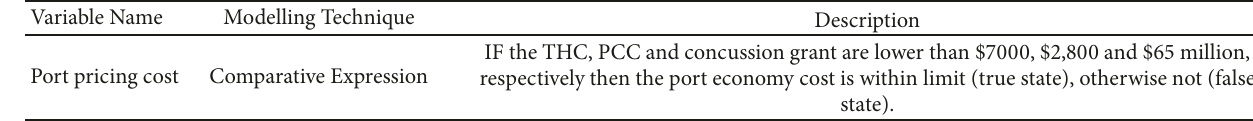
Table 6: Modelling of port pricing